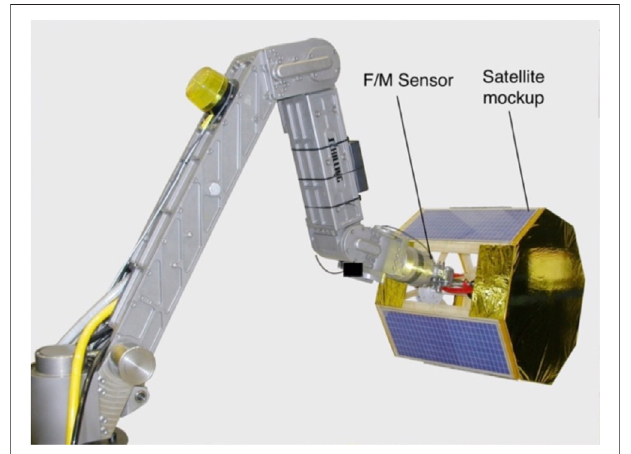
FIGURE 4 | Zero-G satellite simulator